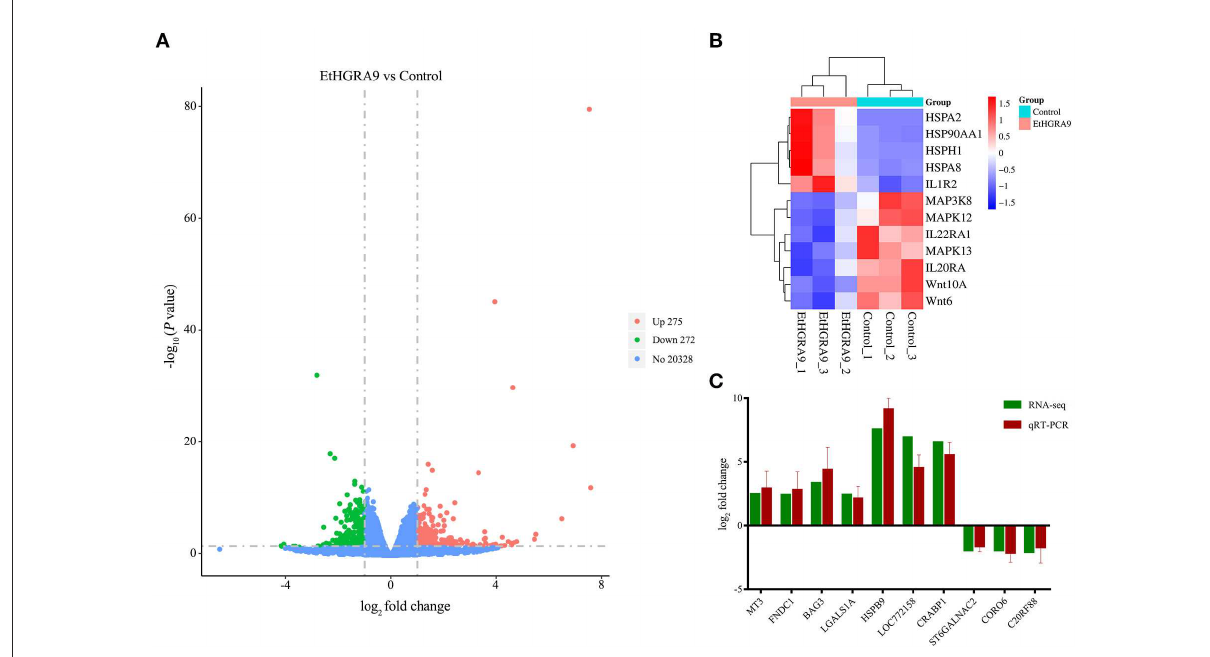
FIGURE3 Differential expression analysis and qRT-PCR validation. (A) Volcano plot analysis of the DEGs between the LMH cells overexpressing EtHGRA9 and control cells. Green: downregulated genes; red: upregulated genes. (B) Heatmap of several DEGs. (C) Ten differently expressed transcripts were analyzed by